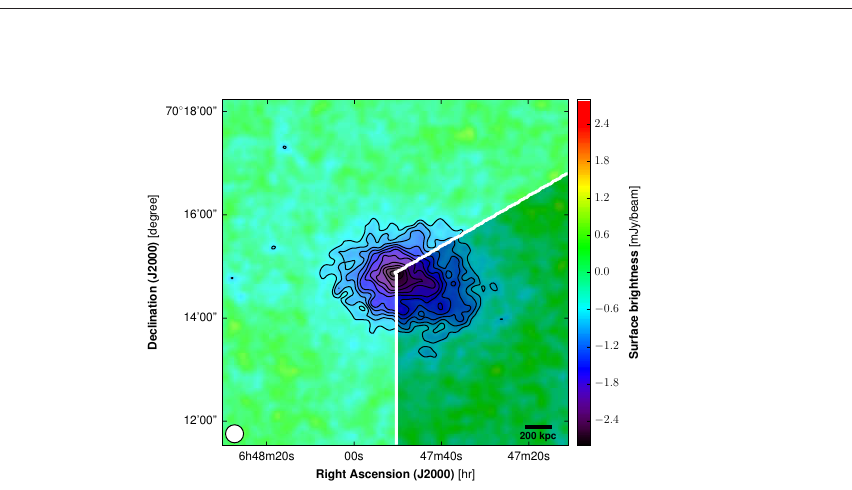
Figure 2. NIKA2 tSZ surface brightness map at 150 GHz after subtraction of the submillimeter point source contaminant. The over-pressure region is shown as a dark sector. Figure extracted from